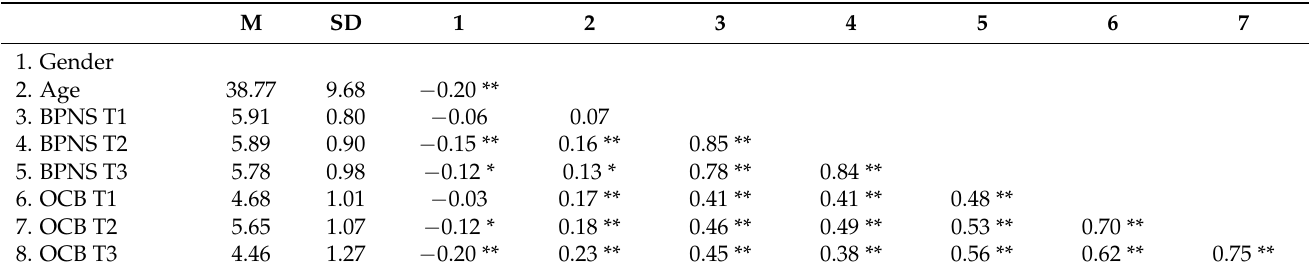
Table 3. Descriptive and inter-correlations for Model 2 variables.